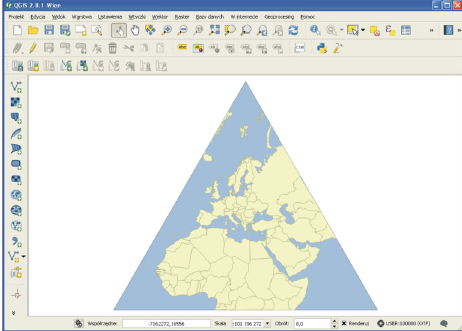
Fig. 22. One of the zones of a map in a gnomomic projection onto a regular